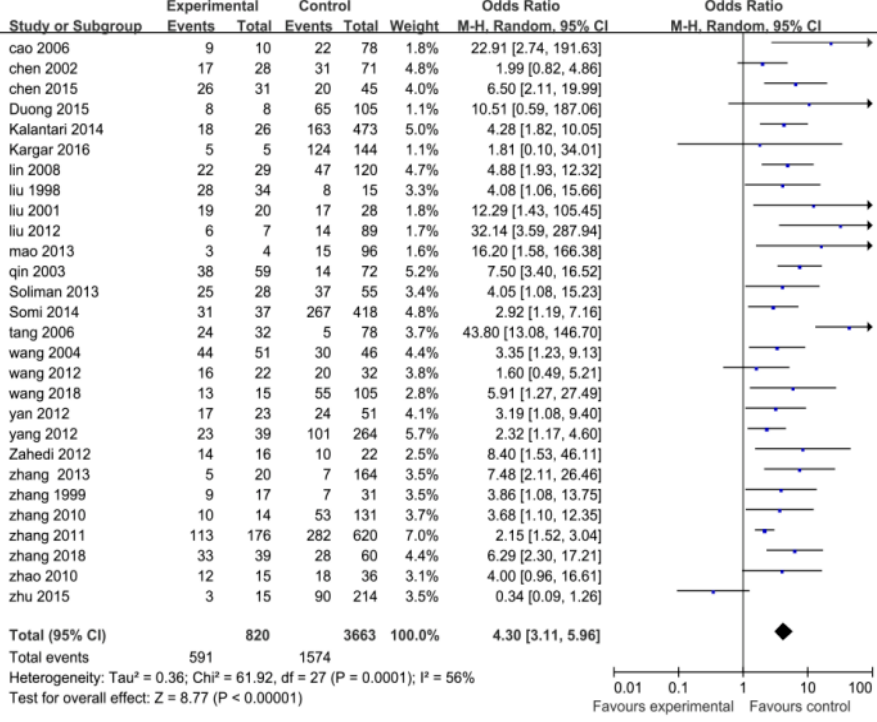
Figure 4. Effects of pooled mean standard deviations (MDs) for duration of hemodialysis (months) correlating to the development of hepatitis C virus infection in hemodialysis patients.